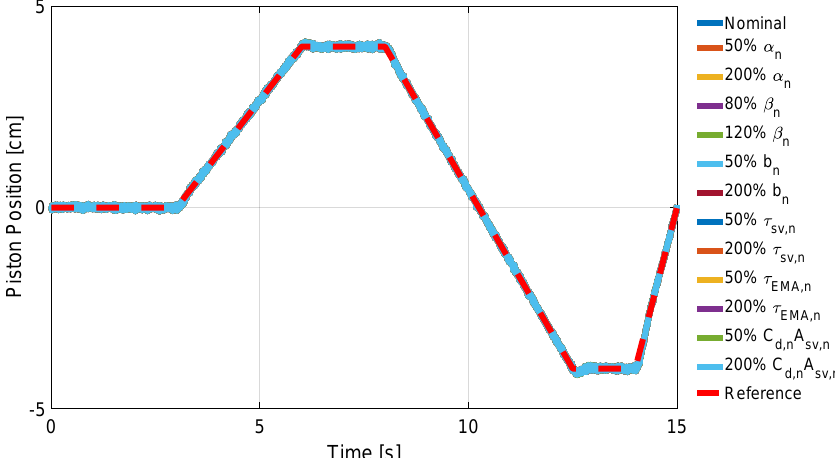
Figure 12. Simulation #2: Piston Position compared to the reference signal.